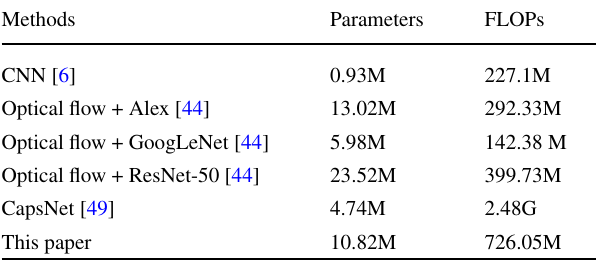
Table 8 Complexity comparison with other methods